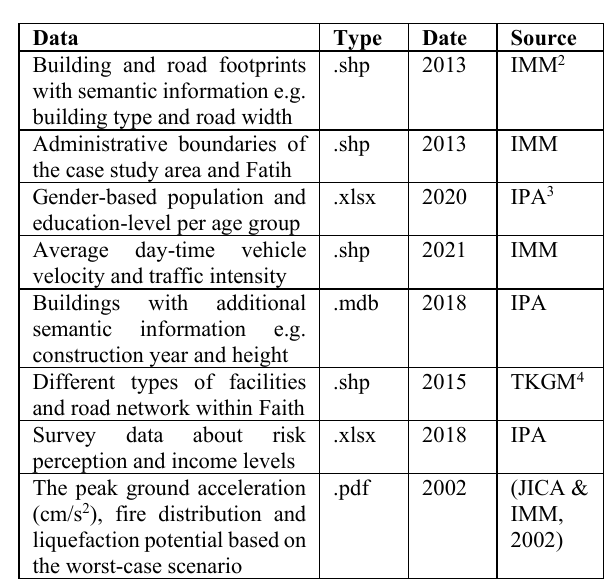
Figure 2 . Research design of this study. Source: de Vries, 2022